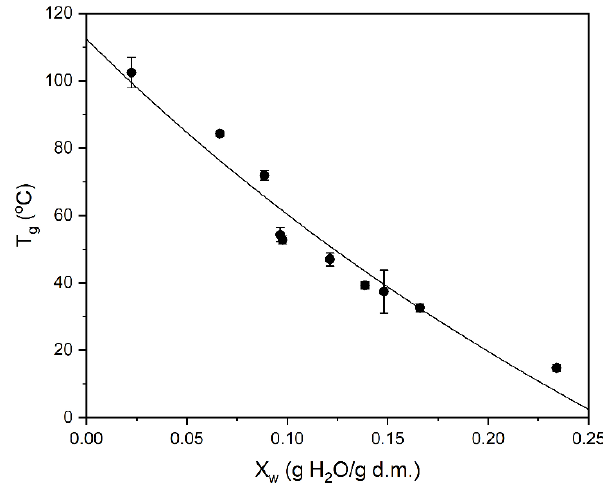
Figure 1. The effect of water content on the T g values measured by DSC. Solid black circles with error bars indicate data points. The solid black line indicates the fit according to the Gordon and Taylor formula given by Equation (3), as described in the